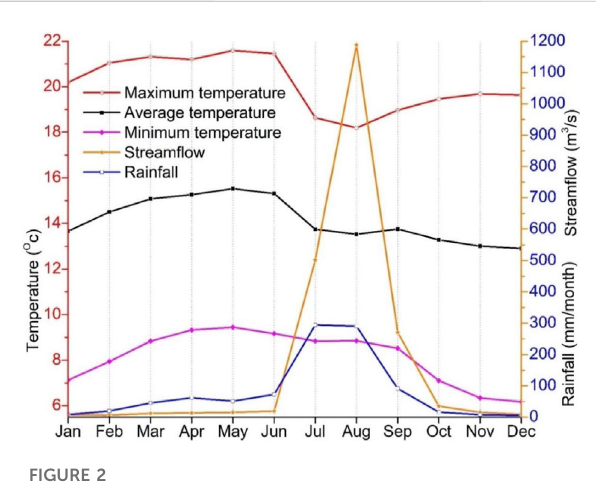
FIGURE 2 Averagemonthlyrainfall,stream fl ow,andtemperaturepatternof the Chacha Watershed from 1986-2019, whereas the stream fl ow was shown from